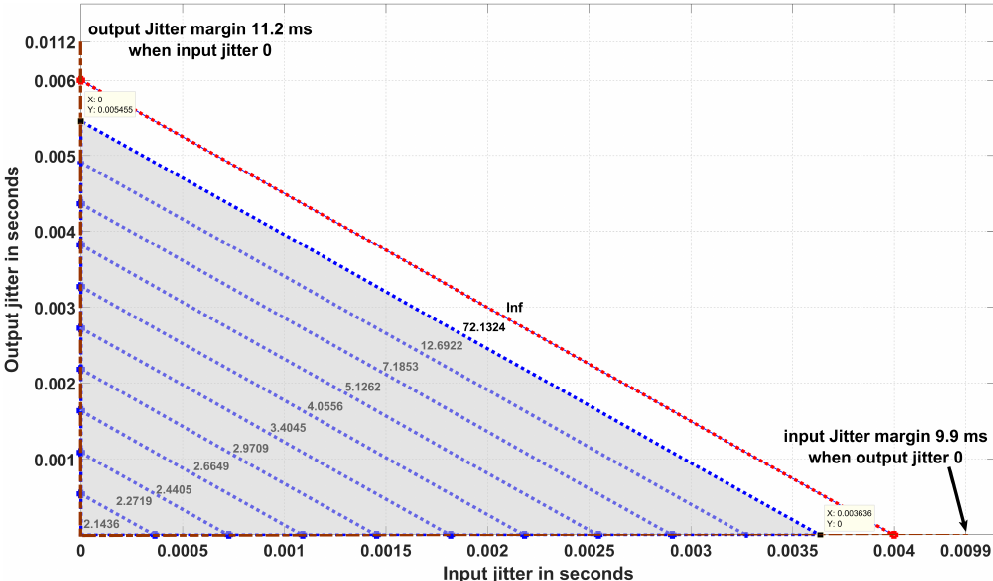
Figure 7. The worst-case control cost calculation during various input and output jitter